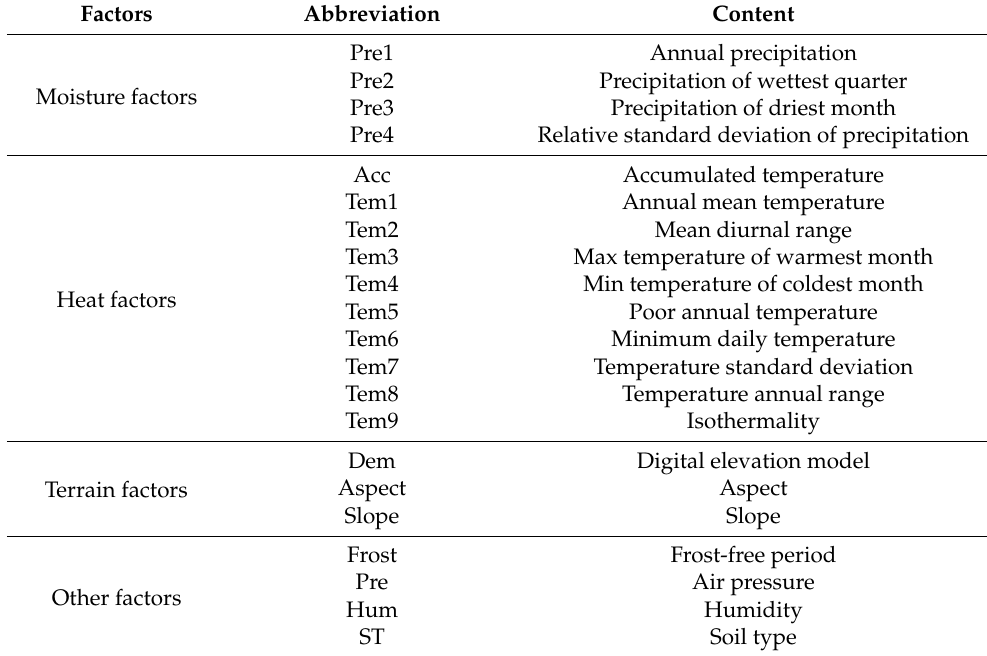
Table 1. Geographical environment